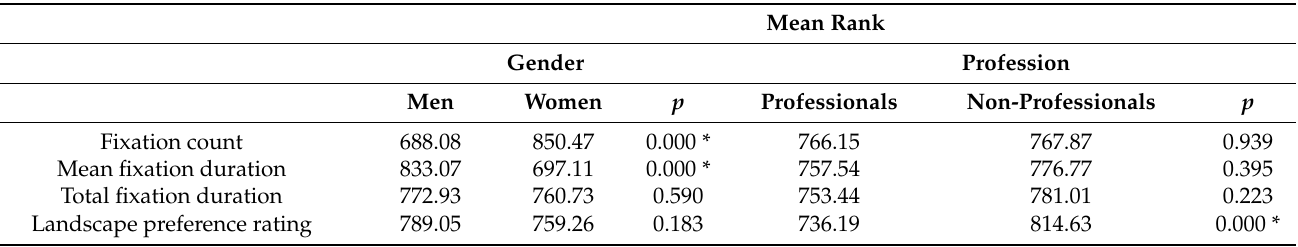
Figure 7. Correlations between preference ratings and gaze metrics of vegetation landscapes com- posed of plants of different geometrical forms.